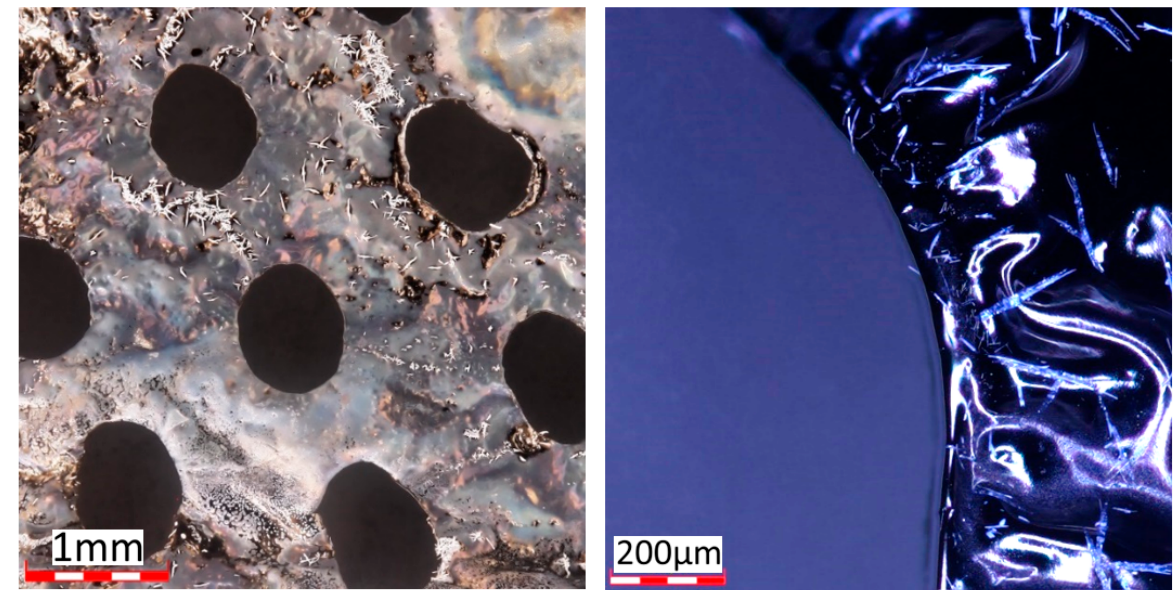
Figure 7. Optical microscope image of the carbonized film.